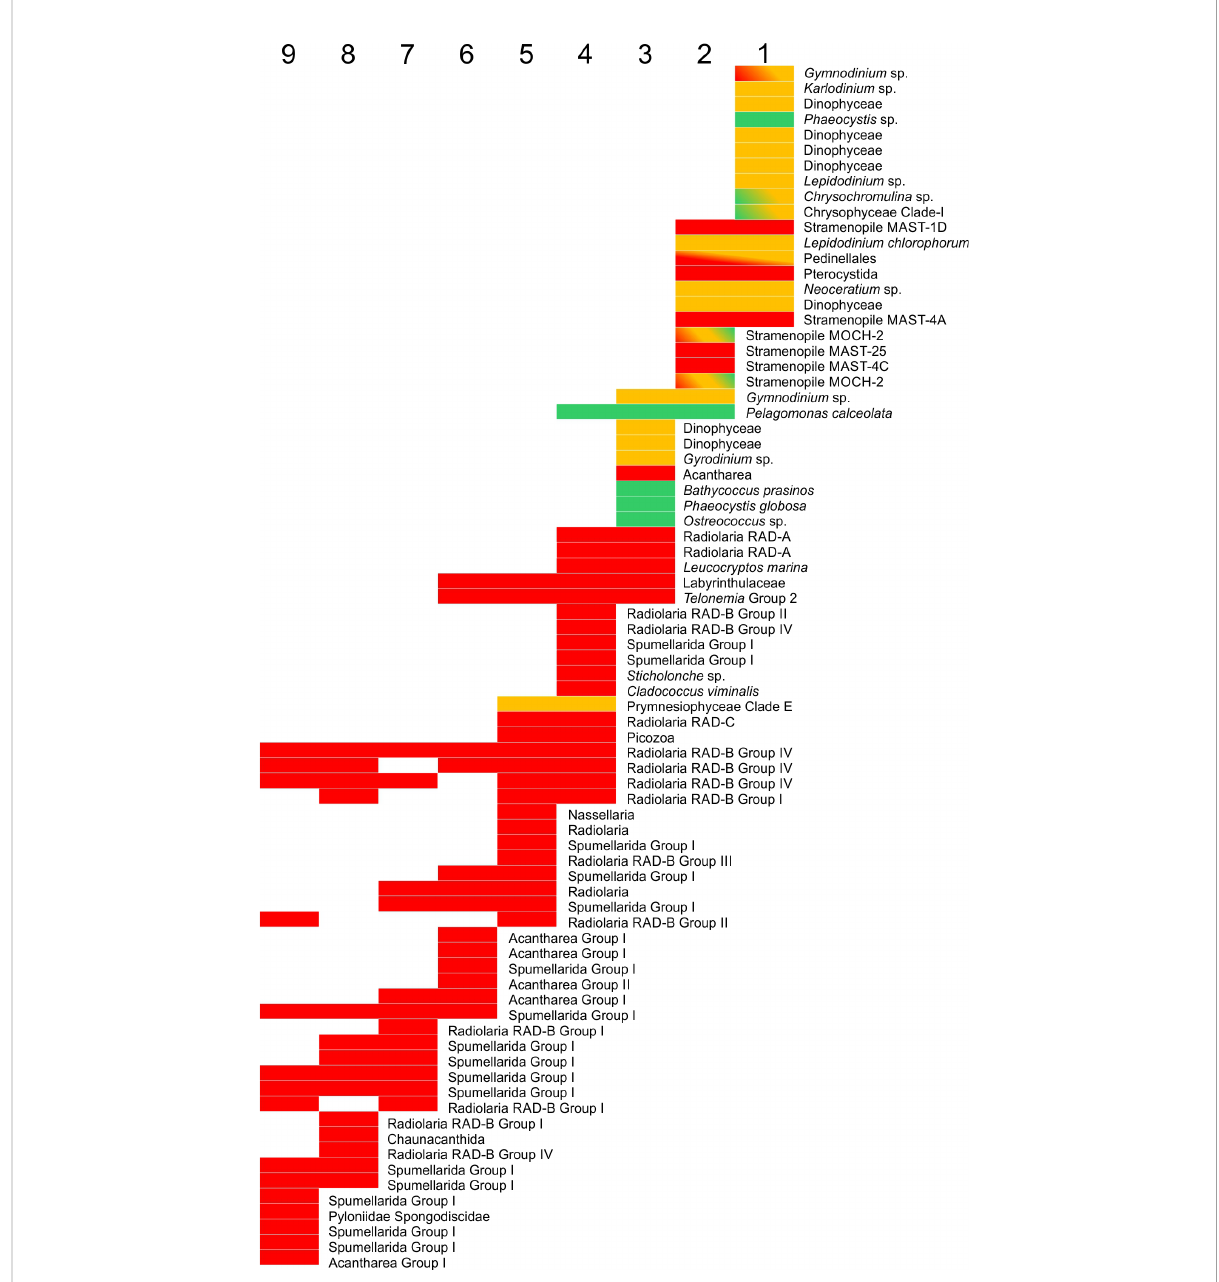
FIGURE 5 Functional pro fi le (red: heterotroph, orange: mixotroph, green: autotroph) for each of the main components of the nine clusters, as indicated by the SIMPER analyses (after removal of parasitic lineages). When the V4 region was shared among lineages with different functional pro fi les, the corresponding colors are indicated in the